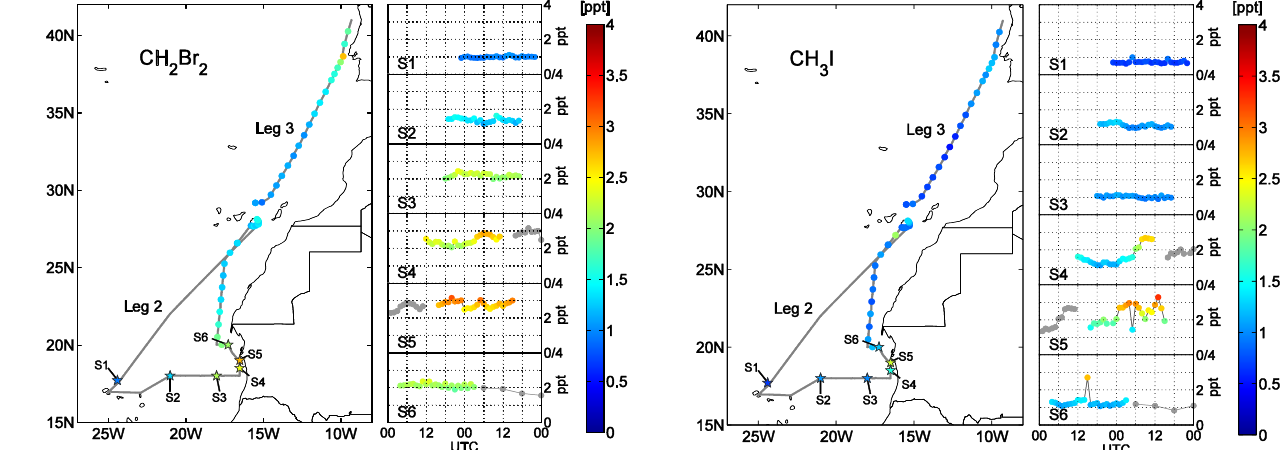
Fig. 9. Methyl iodide mixing ratios [ppt] measured during the 703 DRIVE ship campaign from 31 May to 24 June 2010. Six 24h sta- Fig. 9: Methyl iodide mixing ratios [ppt] measured during the DRIVE ship campaign from 704 tions (S1–S6) and measurements during transit are colour-coded ac- cording to the scale on the right 31.05. to 24.06.2010. Six 24 hr stations (S1 – S6) and measurements during transit are color-705 coded according to the scale on the right side. 706 707